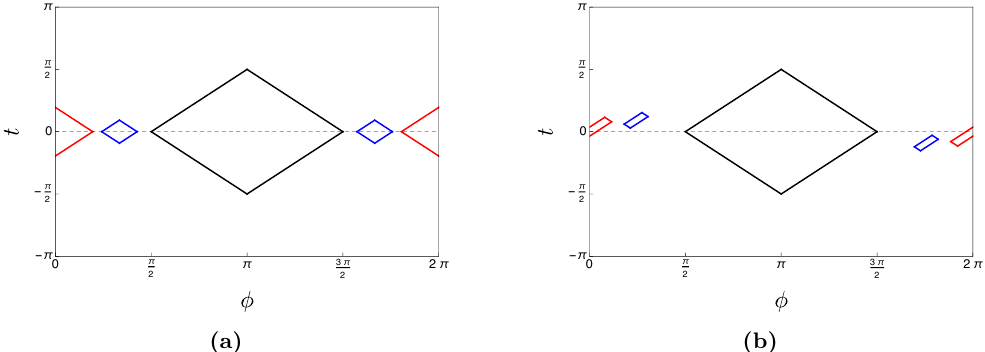
Figure 6. The fundamental diamonds of (3 , 0) geometry at the boundary of AdS 3 in global coordinates. The fixed points p diamonds. The diamonds of regions 1, 2, and 3 are bounded by black, red, and blue lines respectively. In (a), the parameters are ‘ 3˜ ‘ i = ‘ i = 3 for the rotating